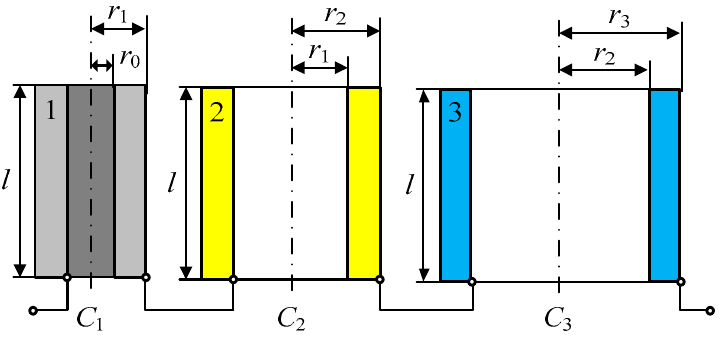
Figure 5. The electrical MCC model.